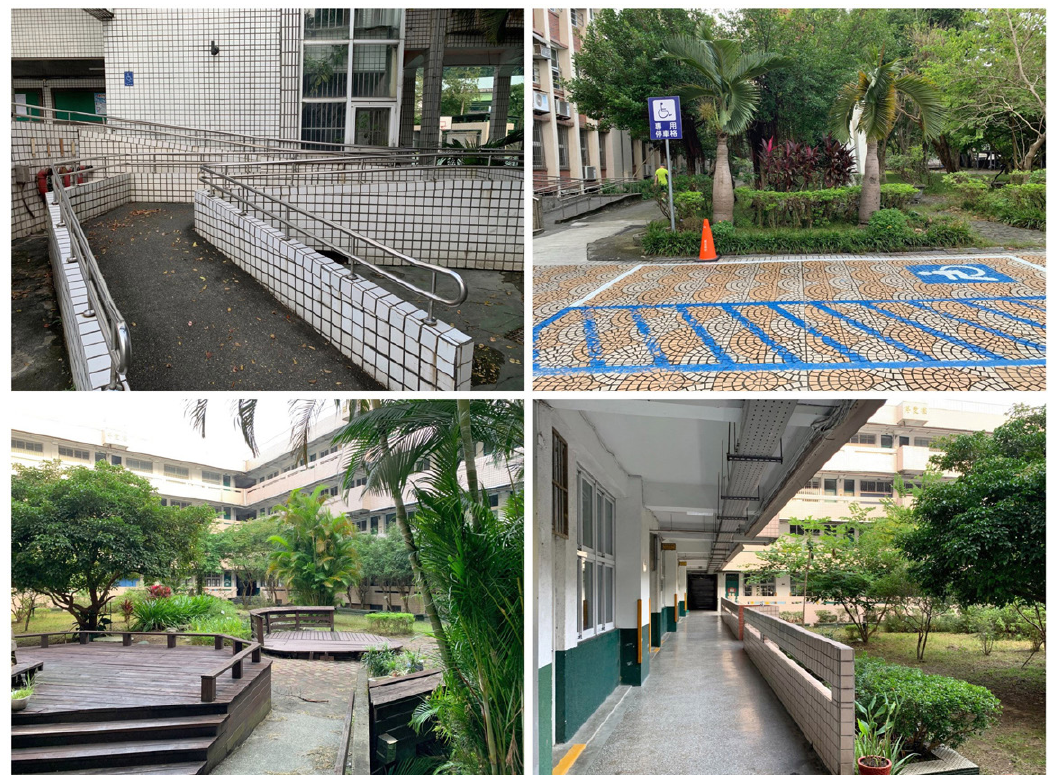
Figure 3. Facilities of indoor and built